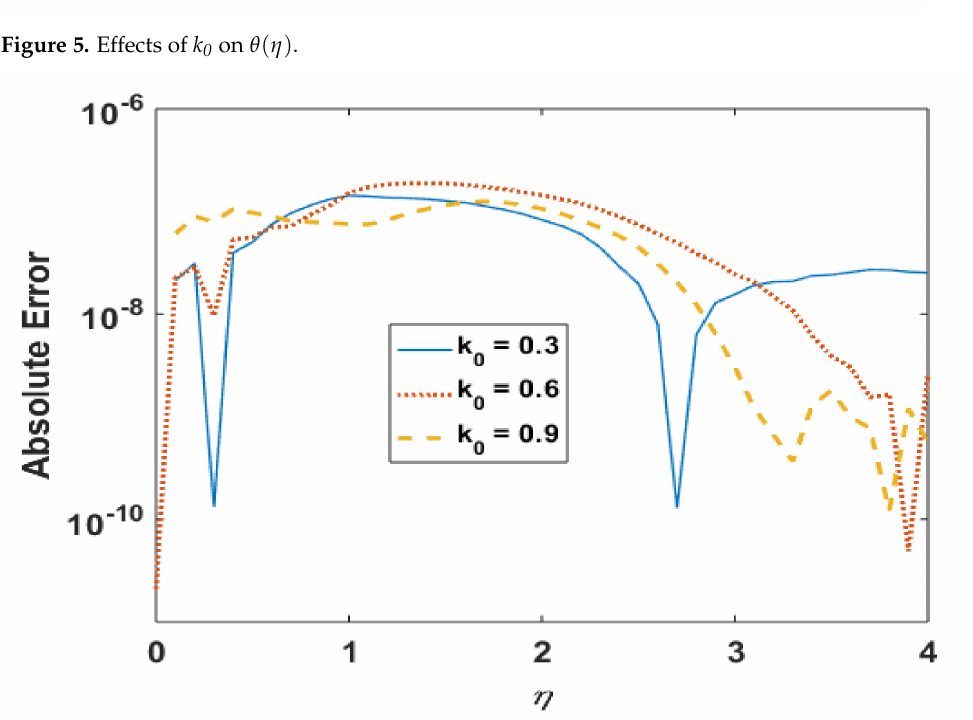
Figure 6. Absolute error in θ ( η ) for different k 0